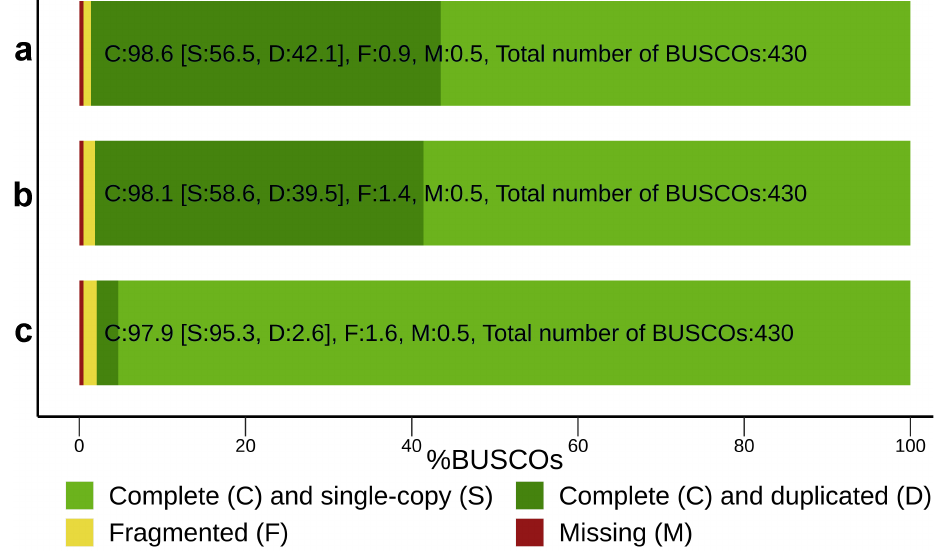
Figure 2. Assessment of BUSCO content improvement during transcriptome assembly